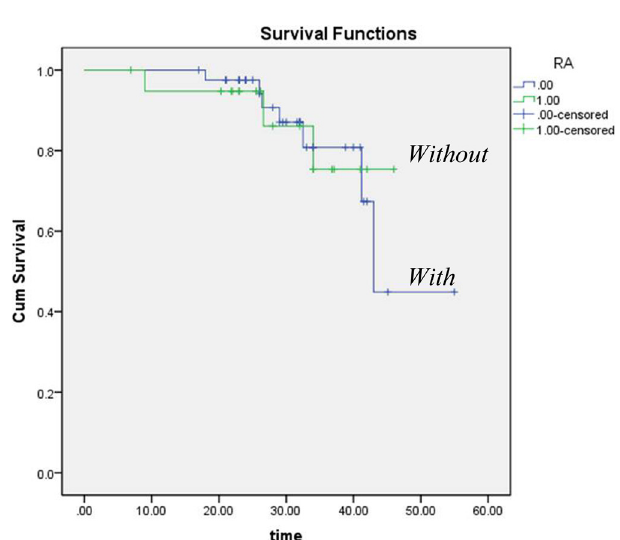
Fig. 3 - Kaplan-Meier analysis revealed that pathological changes of the radial artery graft were not a significant risk factor affecting the survival rate. The long-term survival rate was 83.6%, 82.9% and 85.0% for overall, patients with and without pathological changes of the radial artery.